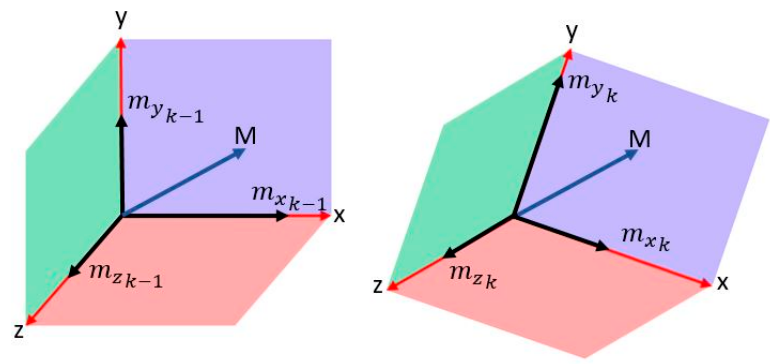
Figure 12. Magnetometer orientation change for a constant magnetic field and corresponding components change.